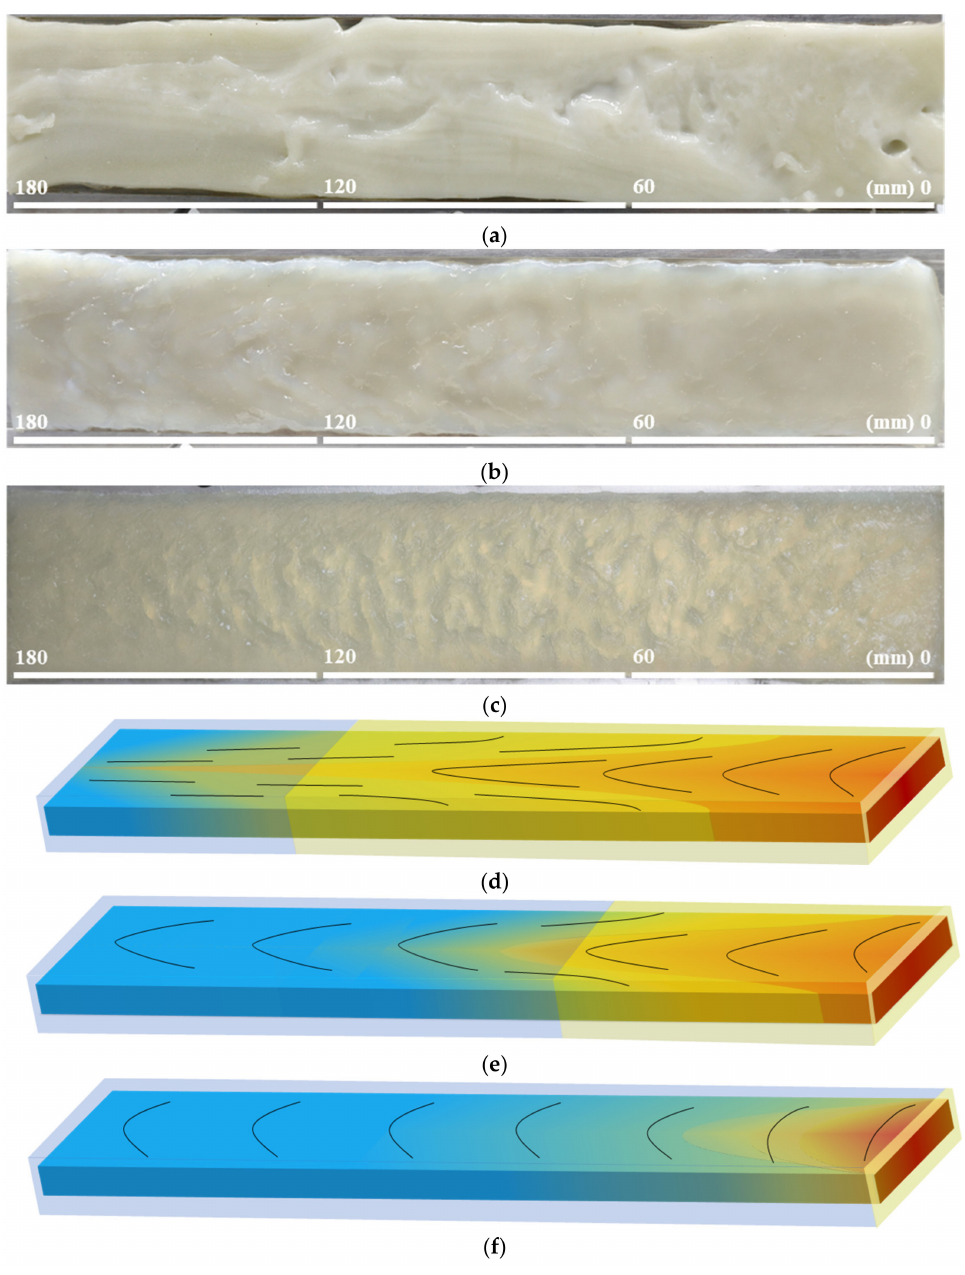
Figure A1. Structural appearance of viscoelastic material in the forming section after the dead-stop trials ( a – c ) and example illustration of the temperature profile with predominant flow pattern (black lines) under the corresponding conditions ( d – f ). The white bar represents the distance traveled by materials in the sheet die. The flow direction is from right to